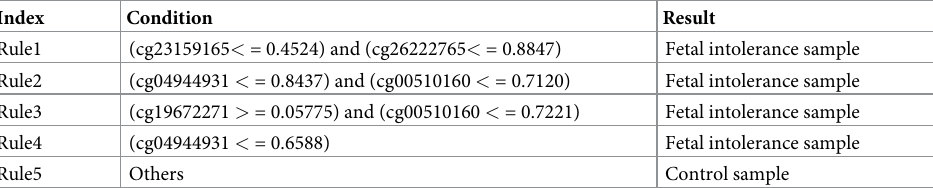
Table 4. Decision rules generated by RIPPER on selected features.